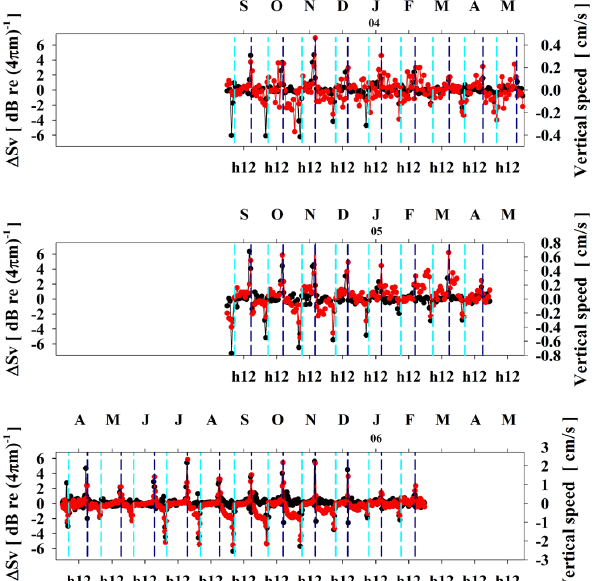
Fig. 8. Monthly mean daily cycle of temporal derivative of backscatter strength and vertical speed at 40m depth for the three deployments: (top) 2003–2004, (middle) 2004–2005, and (bottom) 2005–2006. Vertical dashed lines correspond to hour of sunrise (cyan) and sunset (blue) of each month. Time axis aligned from April of one year to May of the following year. Year is indicated below January label.